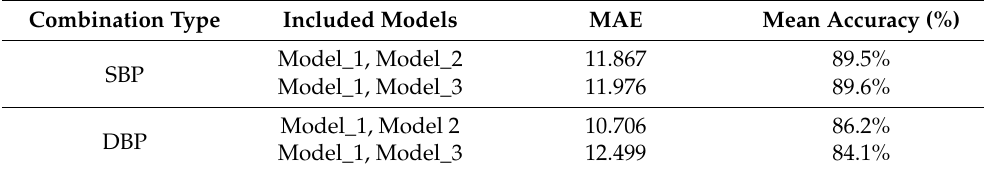
Table 4. Best combinations based on the lowest MAE and highest mean accuracy.